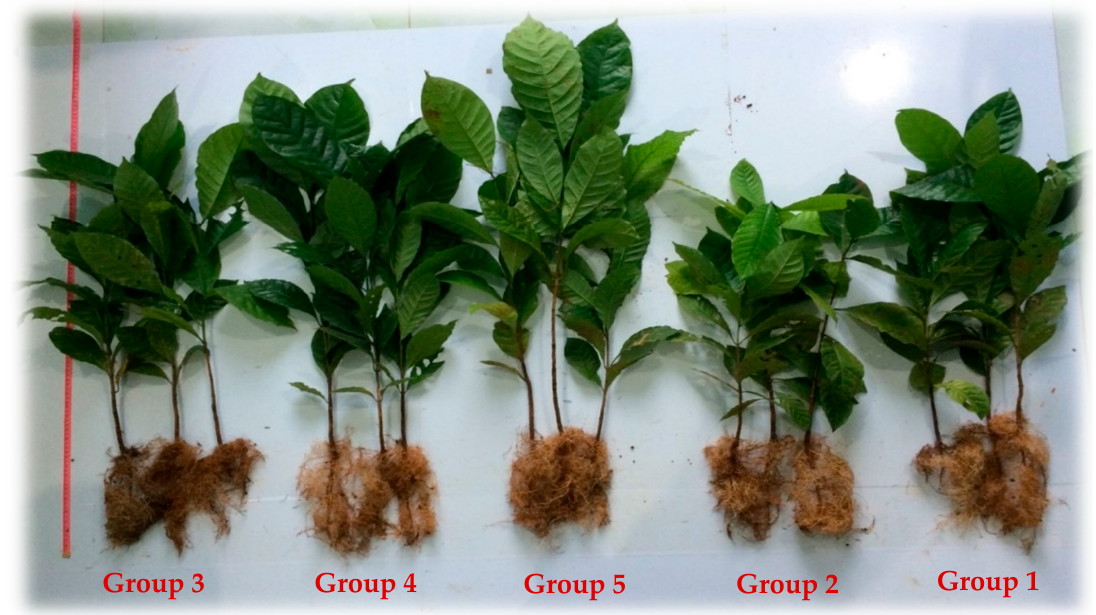
Figure 4. The harvested coffee seedlings after three months of experimental cultivation in the greenhouse. The coffee